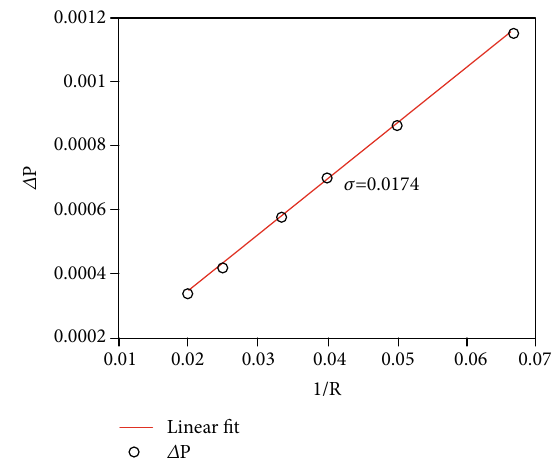
Figure 4: The relationship of pressure di ff erence Δ P between the water and gas phases and the droplet radii R